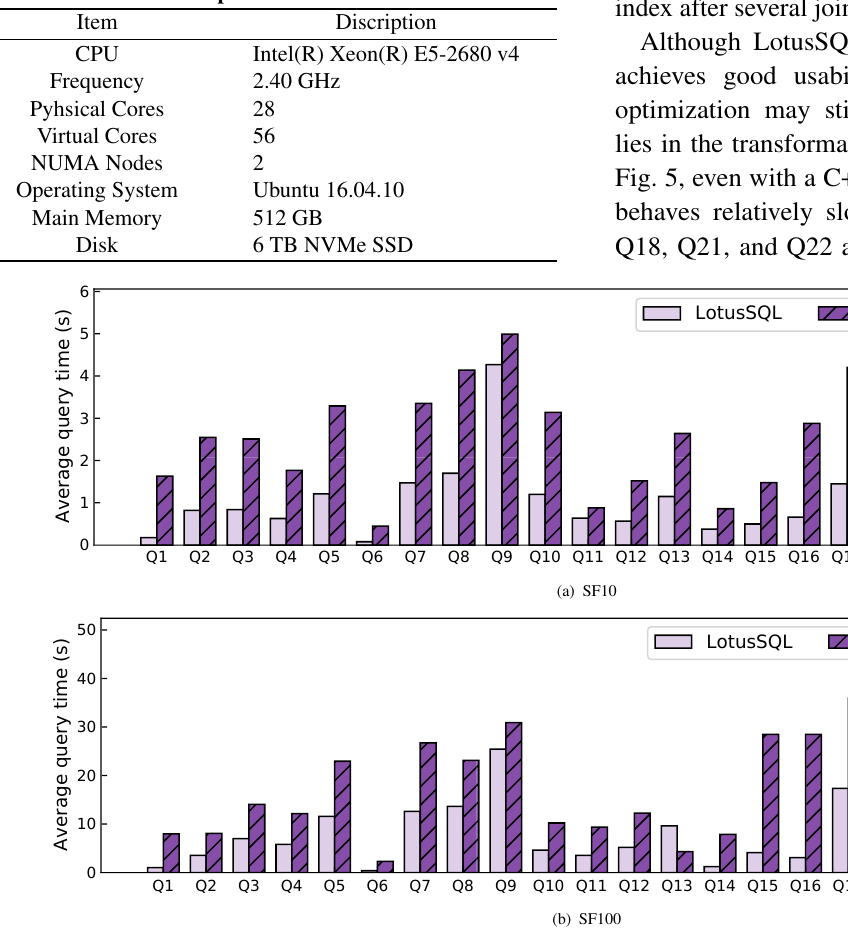
Fig. 5 TPC-H computing